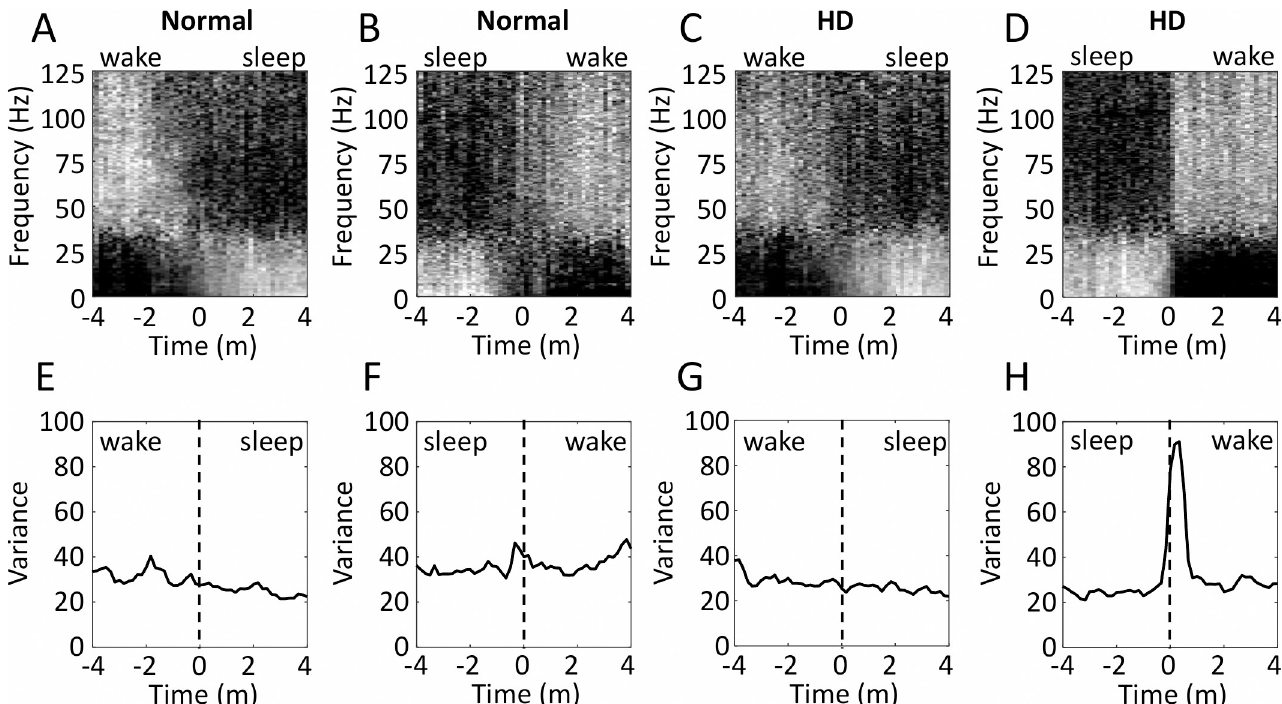
Fig 3. Transitions from sleep-to-wake are more abrupt in Huntington’s disease than normal sheep. Panels A-D show spectrograms of mean transitions from wake-to-sleep (A, C) or from sleep-to-wake (B, D) , for normal ( A, B, N = 5) and HD ( C, D, N = 5) sheep. Each frequency bin in the spectrograms is normalised to itself, such that black represents the minimum power at that frequency during a transition, and white is the maximum. Graphs in E-H show the variance in these normalised frequency power values across all frequencies during a 1 minute moving window. Data in this figure are shown from the A2 L channel.